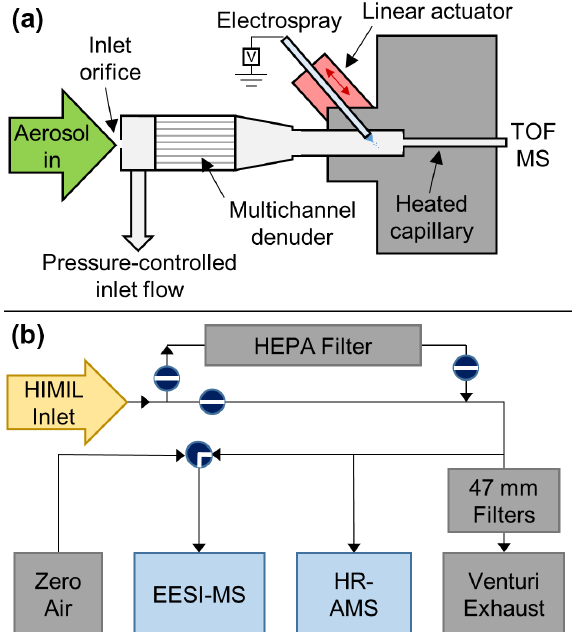
Figure 1. (a) Schematic of the EESI-MS source, pressure- controlled inlet, and automated capillary stage; (b) EESI-MS and HR-AMS sampling configuration flown during FIREX-AQ. The linear actuator controlling the capillary position is opposed by a spring (not drawn) to allow for bidirectional control of the capillary position, as shown by red arrows. The valves in (b) are drawn in the positions used for ambient